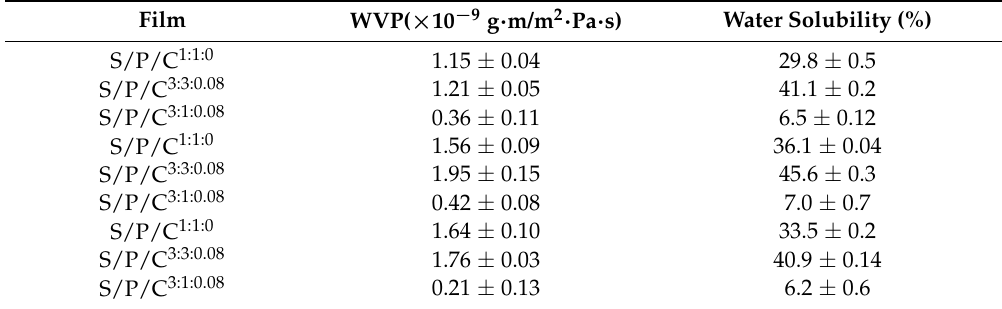
Table 4. The water vapor permeation rate and solubility of starch/polyvinyl alcohol/citric acid ternary blend functional food packaging films.